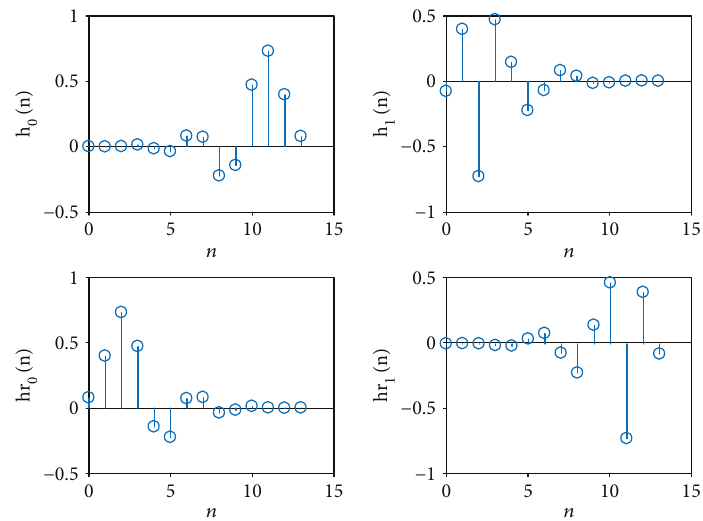
n and h n are low-pass and high-pass decomposition fi lters, respectively. The 0 1